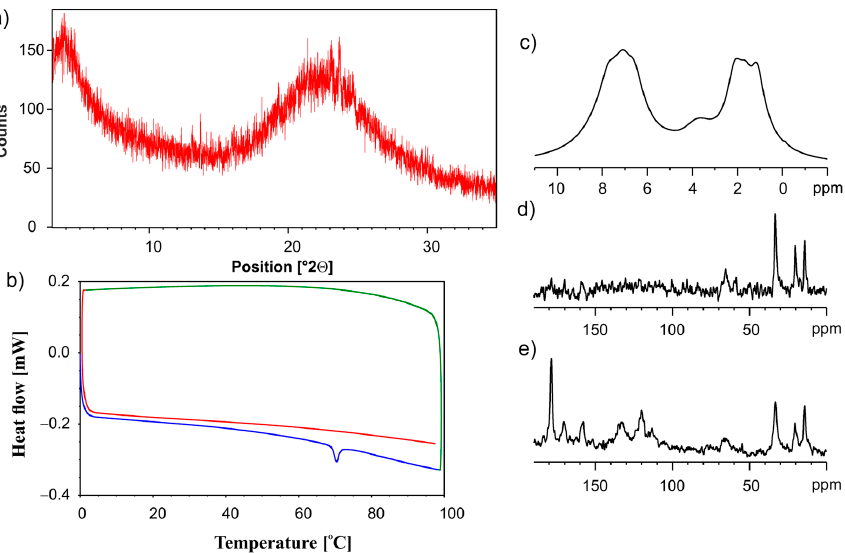
Figure 10. The ( a ) PXRD recorded on a PANalytical 3 kW system in Bragg–Brentano geometry and with a Cu K α ( λ = 1.5425 Å) source, ( b ) the DSC measurement. The fi rst heating run from 0 °C to 100 °C (blue line), then a cooling run from 100 °C to 0 °C (green line), followed by a second heating run from 0 °C to 100 °C (red line), ( c ) 1 H MAS, ( d ) 13 C CP MAS and ( e ) 13 C SPE MAS NMR measure- ments recorded with a spinning rate of 12 kHz for the physical mixture of ET:GLU cocrystal and SiO 2(hydr) after grinding in a ball mill.